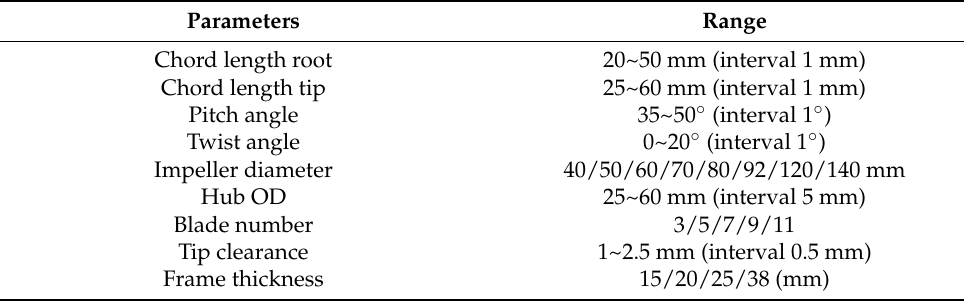
Table 7. Design parameters range.